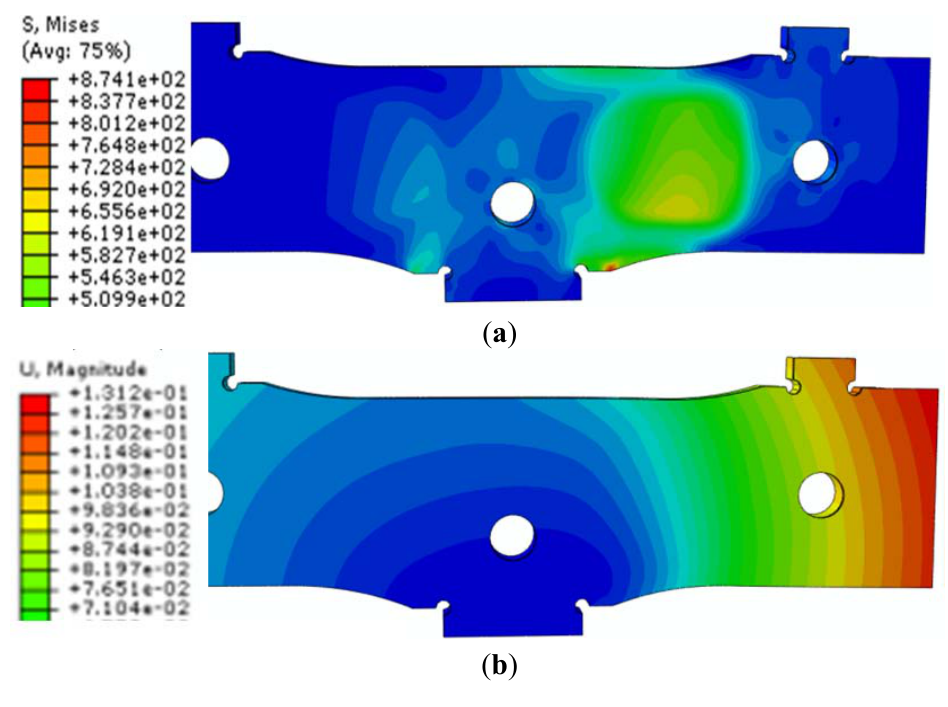
Figure 9. State of von Mises stresses and displacements in the central elastic plate: ( a )